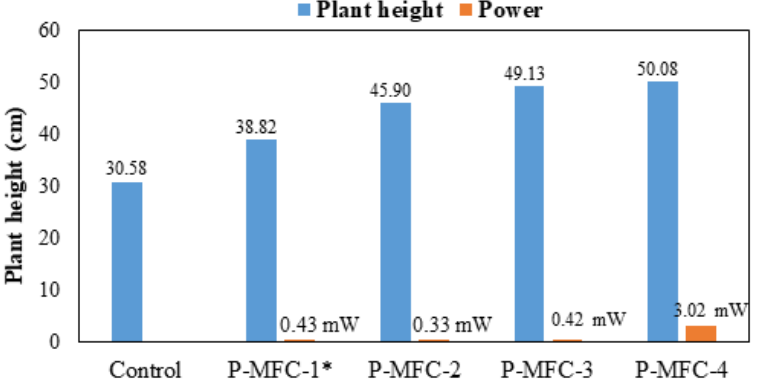
Figure 6. Plant height vs. power generation in the evaluated P-MFC.